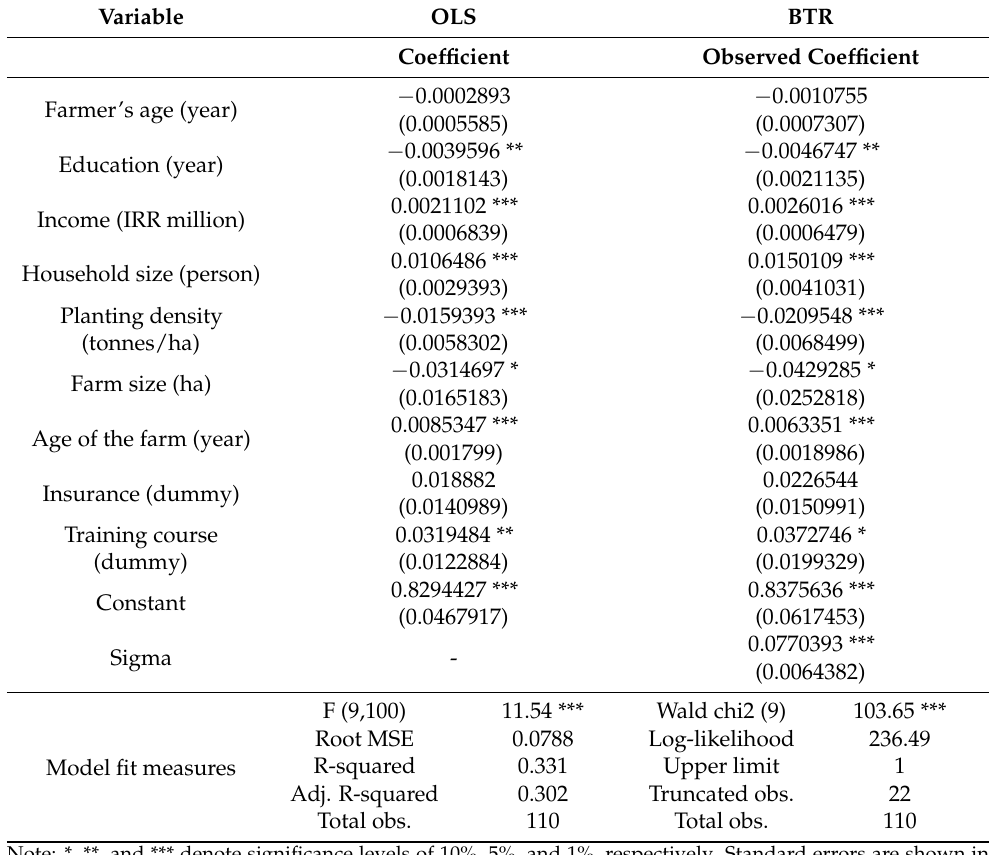
Table 5. OLS and BTR results of factors influencing technical efficiency (cross-sectional